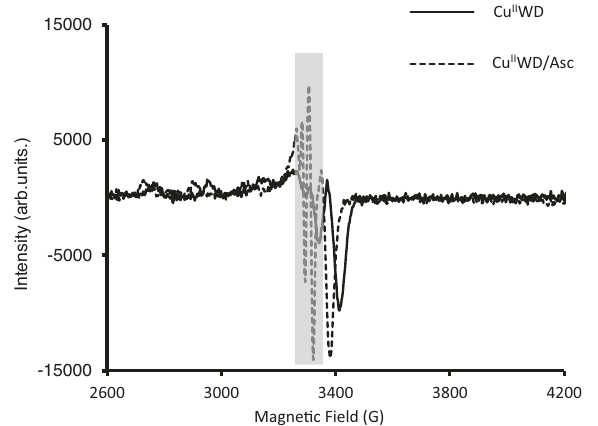
Fig. 4 | EPR measurement of Cu II WD/Asc. The appearance of sharp peaks (gray box) on the electron paramagnetic resonance spectroscopy (EPR) spectra of 0.05mM Cu II WD in presence of 1.00mM Asc indicates the presence of ascorbyl radicalaftertheadditionofAsctoCu II WD.TheresultsshowninFig.4wasmeasured repeatedlytwiceonsamesample(technicalreplicate).Sourcedataareprovidedas a Source Data fi le.